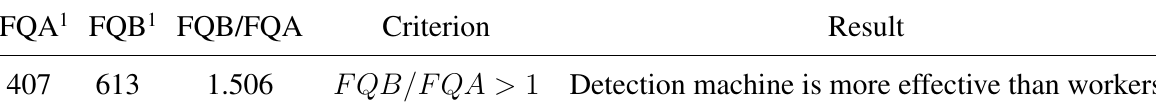
Table 5. Knapp–Kushner testing